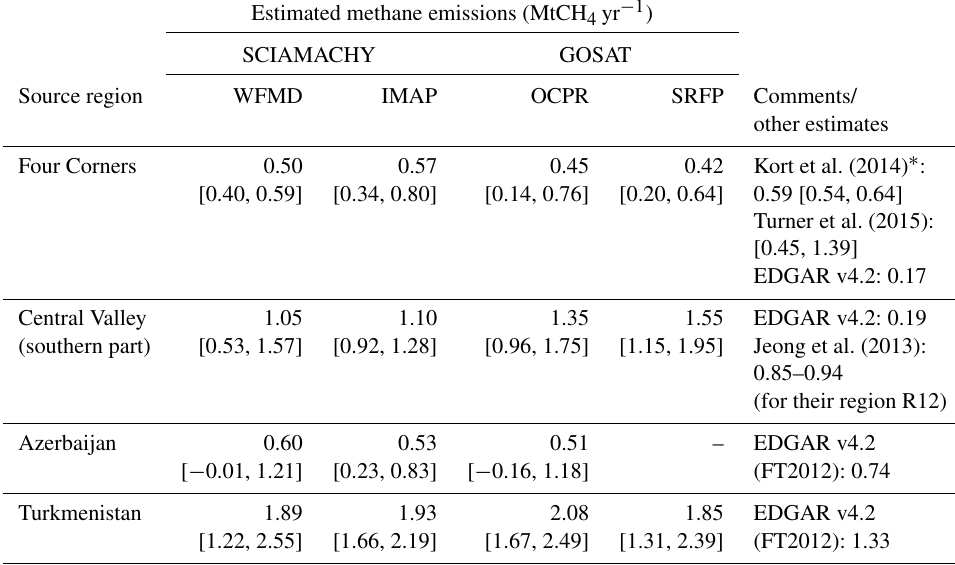
Figure 13. Methane emission estimates for several methane hotspot areas in the USA as obtained by applying out simple mass balance method to the year 2010 GCT15 data set. The figure in the centre is identical with Fig. 8 and shows year 2010 X CH 4 over the USA. For each hotspot region the following three numbers are listed below each map: estimated methane and its uncertainty inktCH 4 yr − 1 for the shown source regions (thick black lines, mostly rectangles). The number in brackets is the percentage difference of the estimated emission and the corresponding true emission (computed as (estimated–true)/true), where the true emission is the source region GCT15 emission. Table 3. Summary of estimated methane emissions in terms of annual mean value and 1 σ range obtained from computing the standard deviation of the annual emissions. The satellite-derived annual methane emissions are covering the time period 2003–2009 for SCIAMACHY and 2009–2014 for